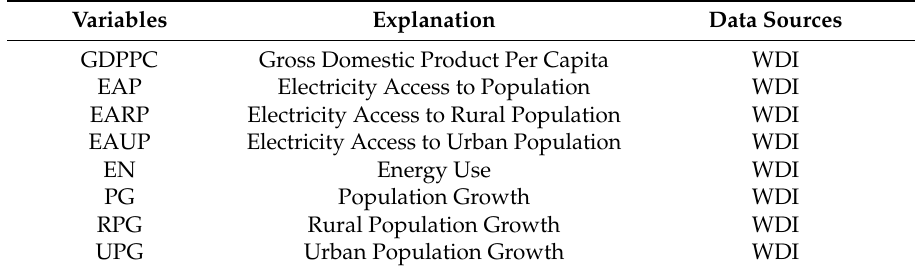
Table 1. Description of Variables and Data Sources. WDI: World Development Indicators.